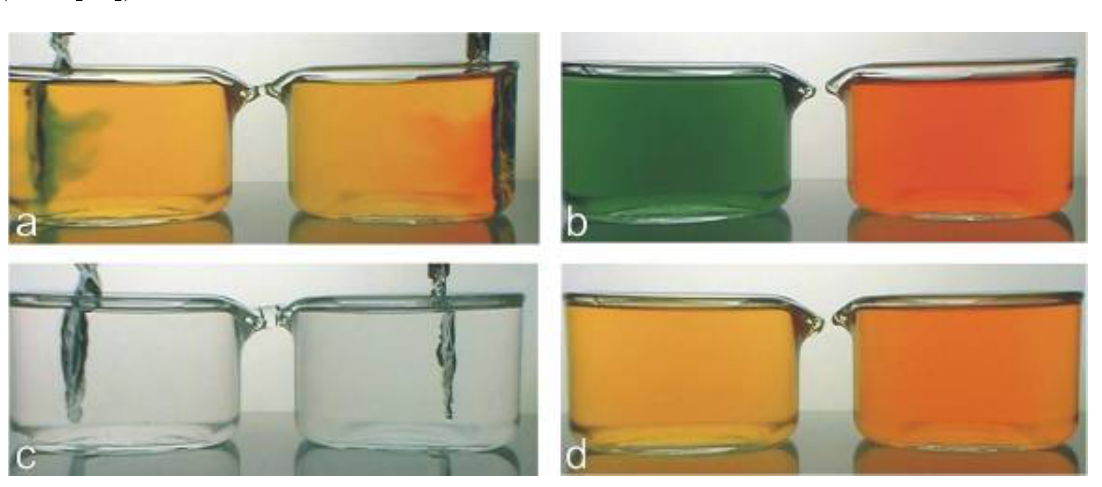
Figure 16. Comparison between bridge operation (~10kV, 30 min) with dye (a,b) and bridge operation without dye (c) and the addition of the dye after shut down (d). (from